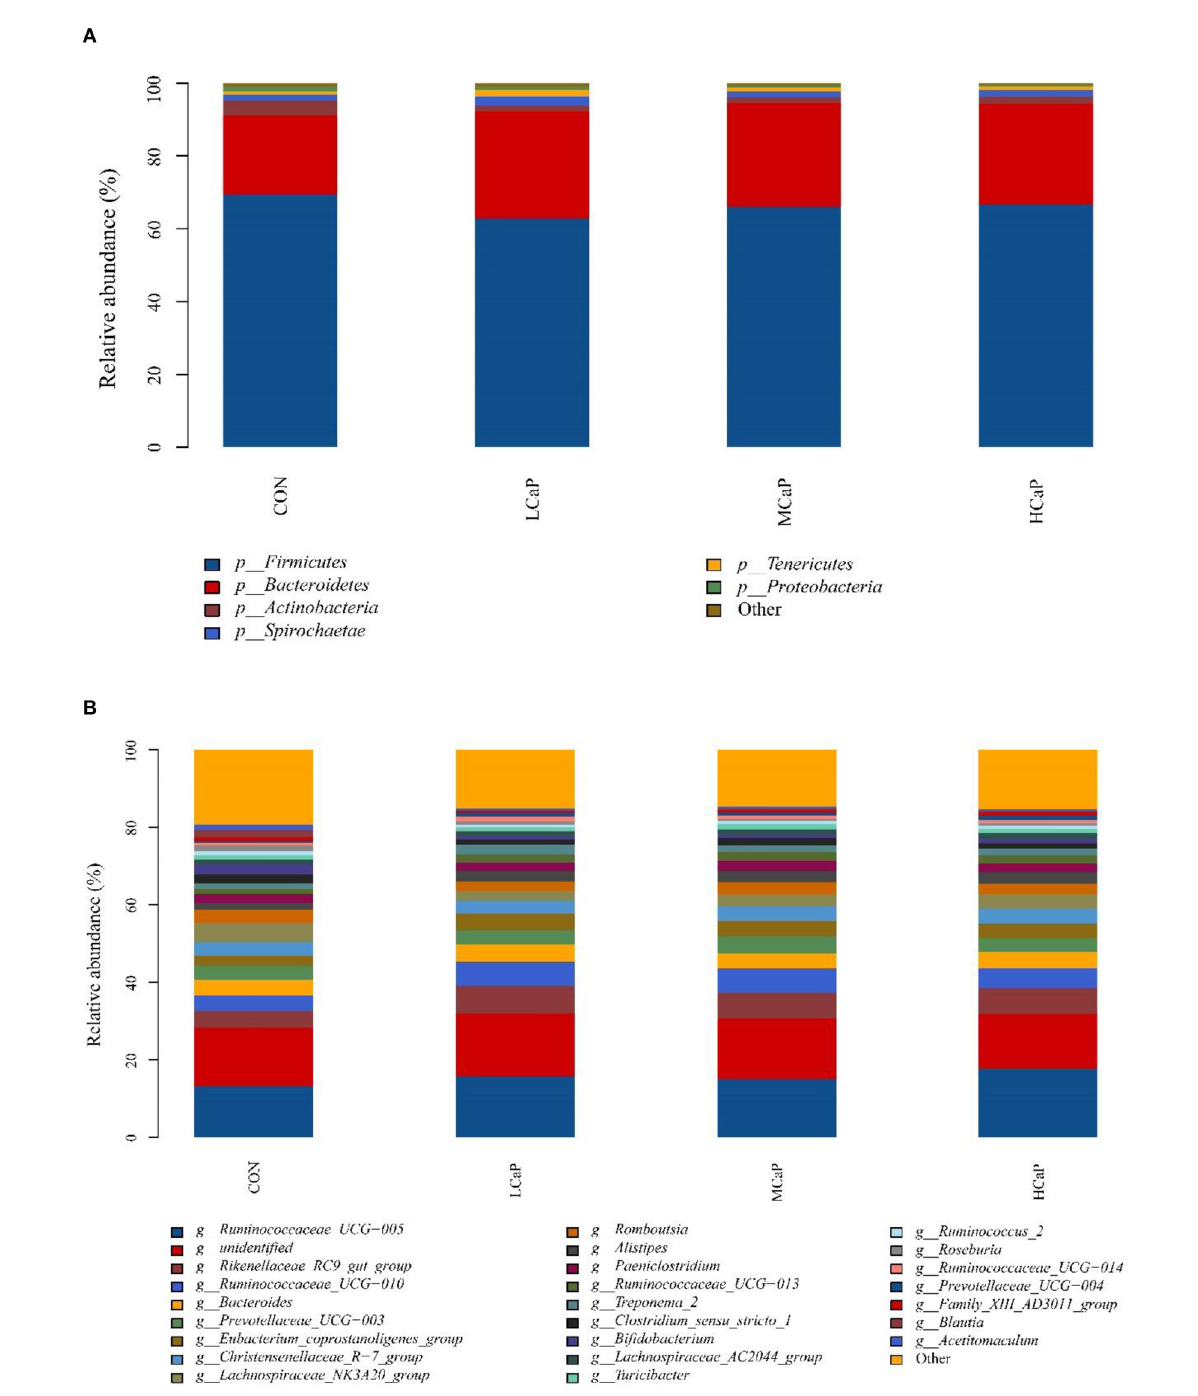
FIGURE3 Distribution of the fecal bacterial community composition under phyla (A) and genera (B) levels across the different levels of calcium propionate treatments. CON, control group; LCaP, low calcium propionate group, basal diet + 200 g/d calcium propionate; MCaP, medium calcium propionate group, basal diet + 350 g/d calcium propionate; HCaP, high calcium propionate group, basal diet + 500 g/d calcium propionate.